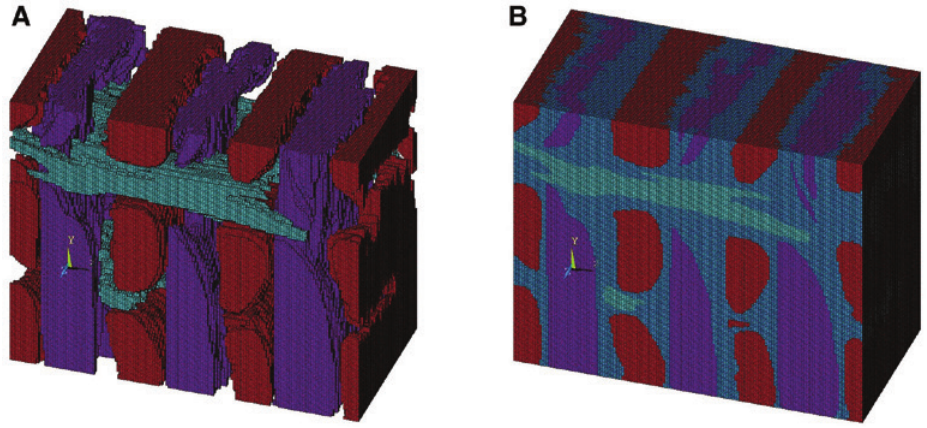
Figure 10: FEM model of the RVE: (A) model without the matrix (only fiber bundles); (B) model with the matrix.